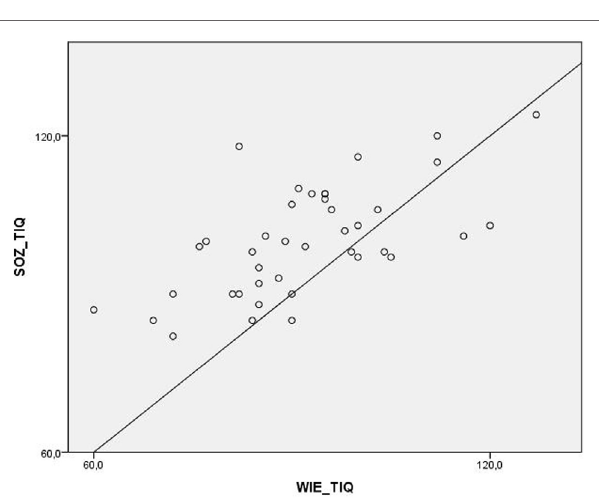
FigUre 1 | Distribution of the total scores of the WAIS-IV and the socio-demographic estimation scale.